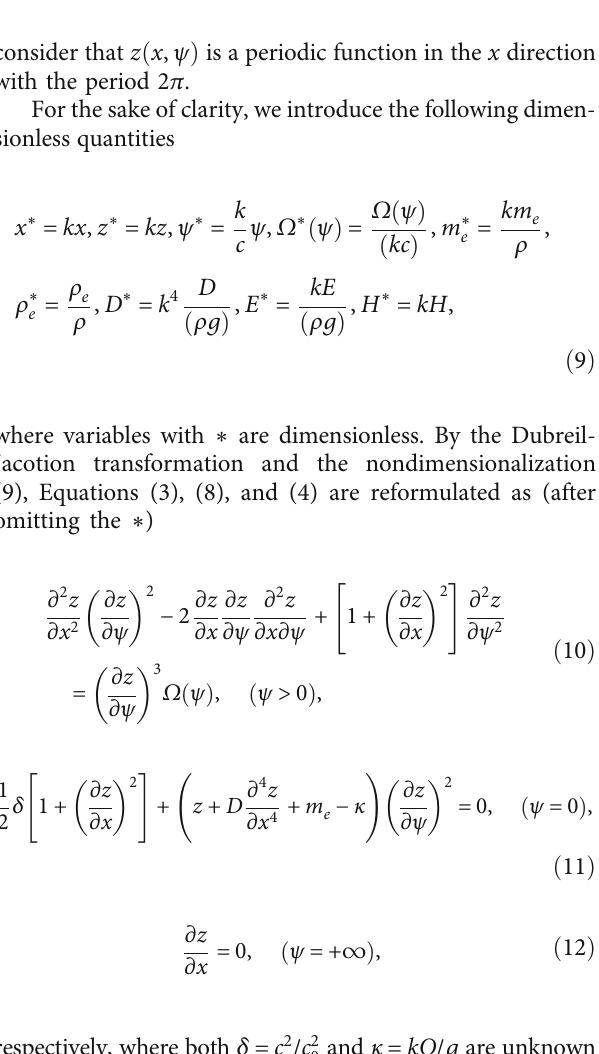
Figure 1: The coordinate